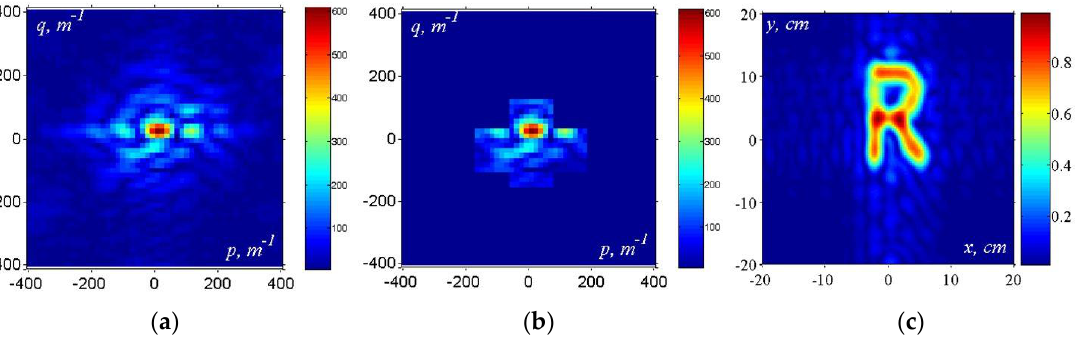
Figure 10. Test object ( a ) and its diffraction-limited image ( b ) — experiment; estimates ( c ) of longitu- dinal  and transversal  resolution for a finite antenna aperture a . Red arrows symbolize complex rays of backward wave migration, blue ellips marks the focal spot size.